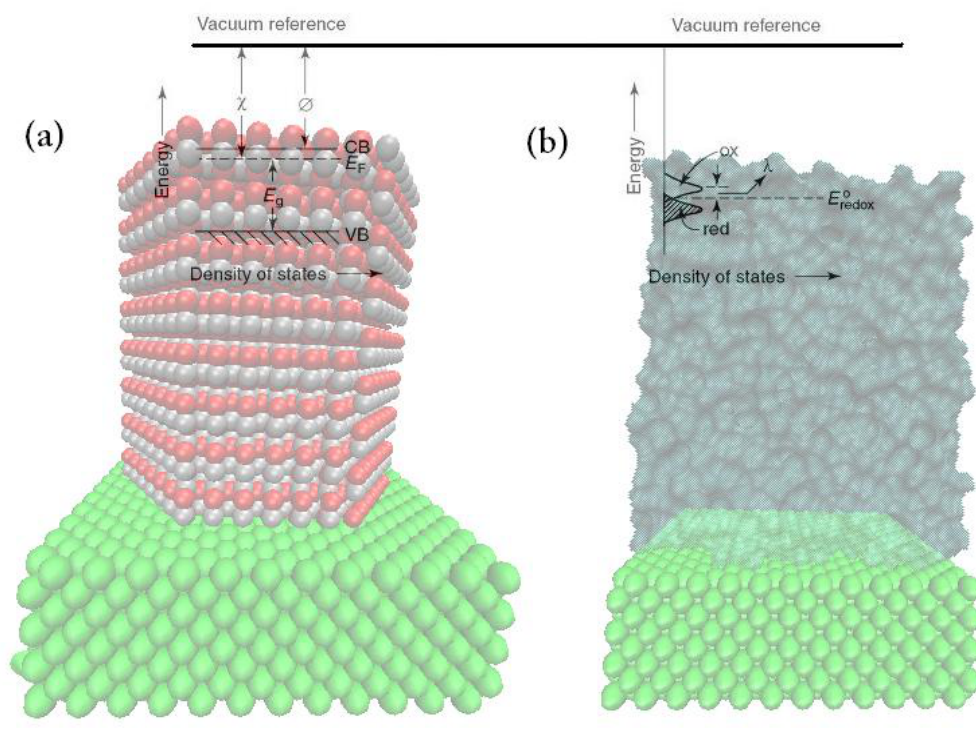
Figure 1. Energy levels in (a) a semiconductor and (b) a redox electrolyte, shown with a common vacuum reference scale, where χ and φ are the semiconductor electron affinity and work function,